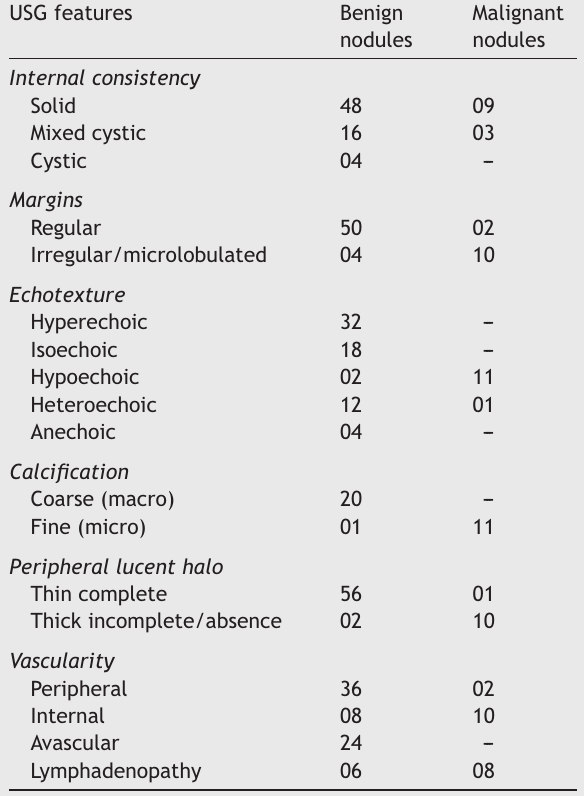
Number of patients with different ultrasonography (USG) features of benign and malignant nodules, distributed among 80